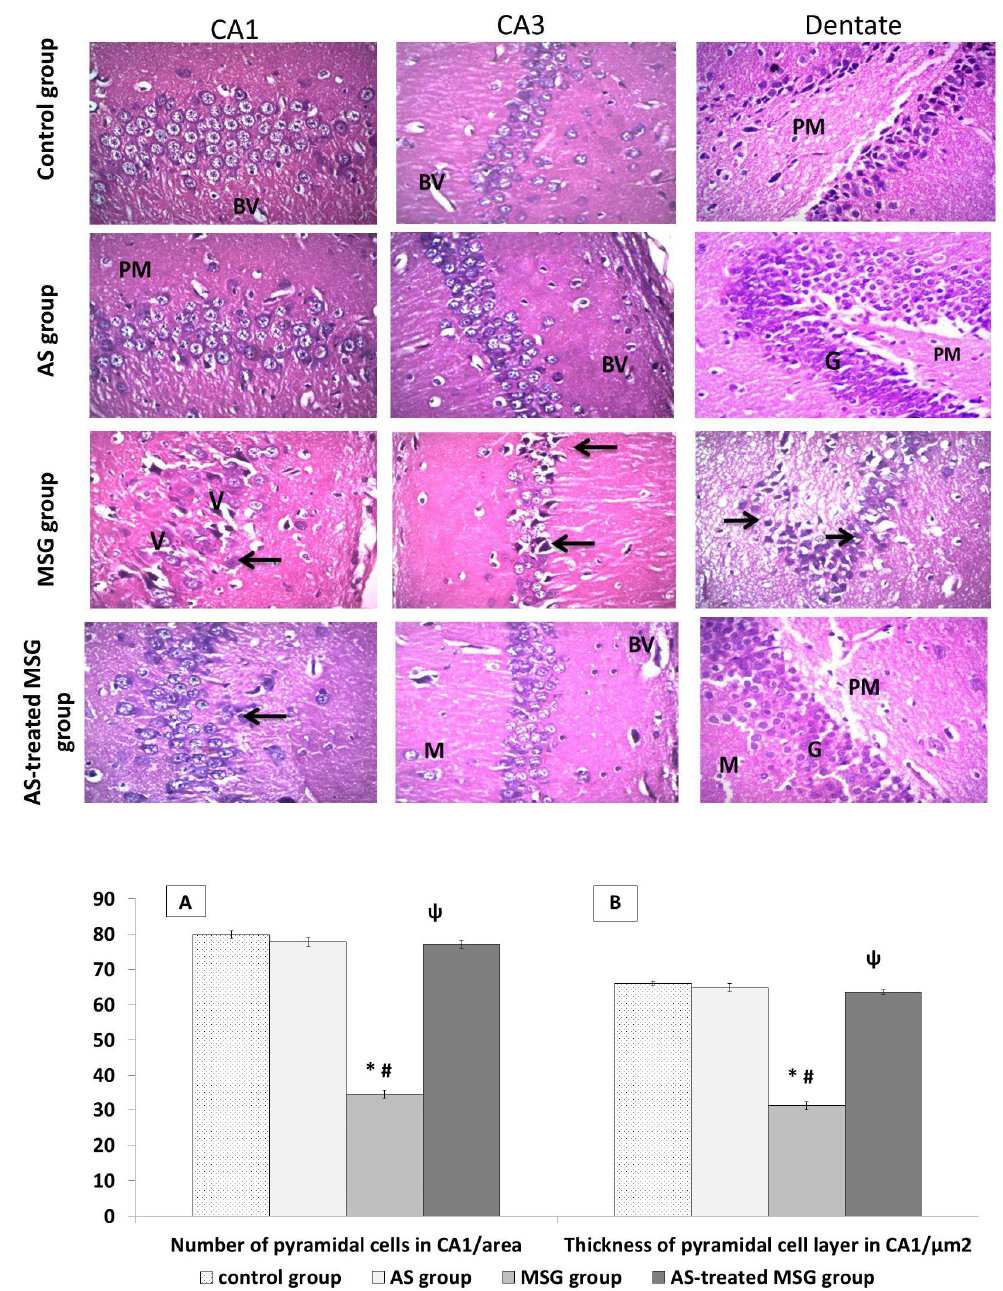
Figure 5. Light microscopic examination of hematoxylin and eosin (H&E)-stained sections in all groups. Control and Allium sativum (AS) groups showed normal histological structure of hippocampus. Monosodium glutamate (MSG) group showed decrease in the number of the cells in Cornu Ammonis (CA1 and CA3) areas with shrinkage and disarrangement of pyramidal cells. Apoptotic and pyknotic nuclei of pyramidal cells surrounded with pericellular haloes. Dilated blood vessels and massive vacuolation of the cytoplasm (V) can be also seen. Dentate gyrus of the same group showed many apoptotic cells (arrows), darkly stained nuclei, vacuolated cytoplasm (V), and disorganized blood vessels (BV). Allium sativum -treated MSG (AS-treated MSG) group was more or less like the control group, with multiple dilated blood vessels. (Hx. &E. X400). Histograms ( A ) and ( B ) indicate significant decrease in pyramidal cell count and layer thickness in the CA1 region in the MSG group compared to the control and AS groups. In addition, the AS-treated MSG group showed a significant increase in these parameters compared to the MSG group. * p < 0.05, vs. control; ψ p < 0.05, vs.